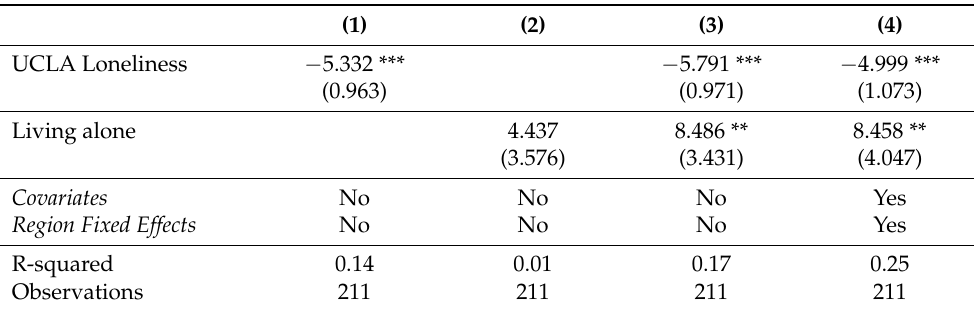
Table 5. Loneliness, living alone, and psychological